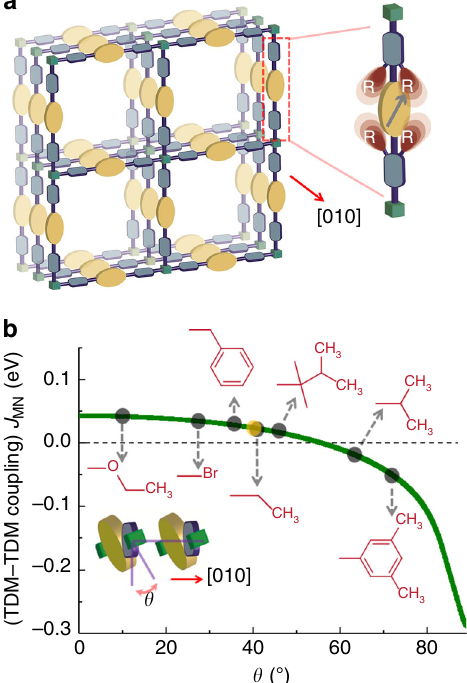
Fig. 1 Prediction of Coulomb coupling in SURMOF-2 structure. a Schematic of a Zn-SURMOF-2 structure showing the continuously stacked chromophores along the [010] plane, with green box = Zn-paddle-wheel type secondary building unit, yellow ellipsoid = NDI(OEt) 2 , black arrow = transition dipole orientation. The schematic at the right-hand side illustrates the linker with the ” SCU ” R. b The green line is a plot of calculated (transition charge from electrostatic potential method, TrEsp) Coulomb coupling vs rotation angle θ (as shown in the inset). The different R groups that exert different values of θ are illustrated on the plotted graph. The yellow sphere marked on the green line is the predicted θ (by GROMACS- 2018.4) without any SCU (R = H); The inset fi gure shows the rotation angle θ controlled by the R